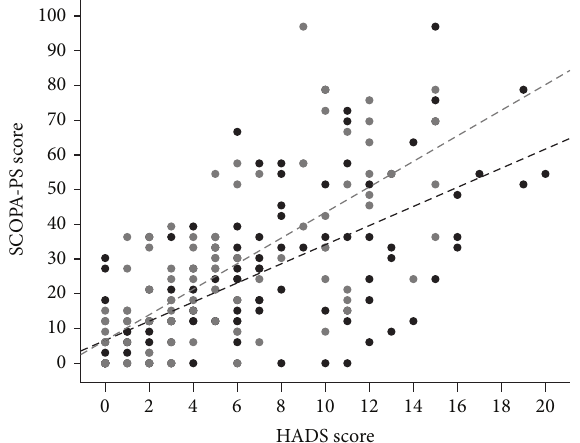
Figure 1: Scatter plot of the correlation between total score of SCOPA-PS and HADS questionnaires for anxiety (black circles; Spearman Rho = 0.642, 𝑃 < 0.001 ) and depression (gray circles, Spearman Rho = 0.715, 𝑃 < 0.001 ) in Iranian Parkinson’s disease patients ( 𝑛 = 110 ).